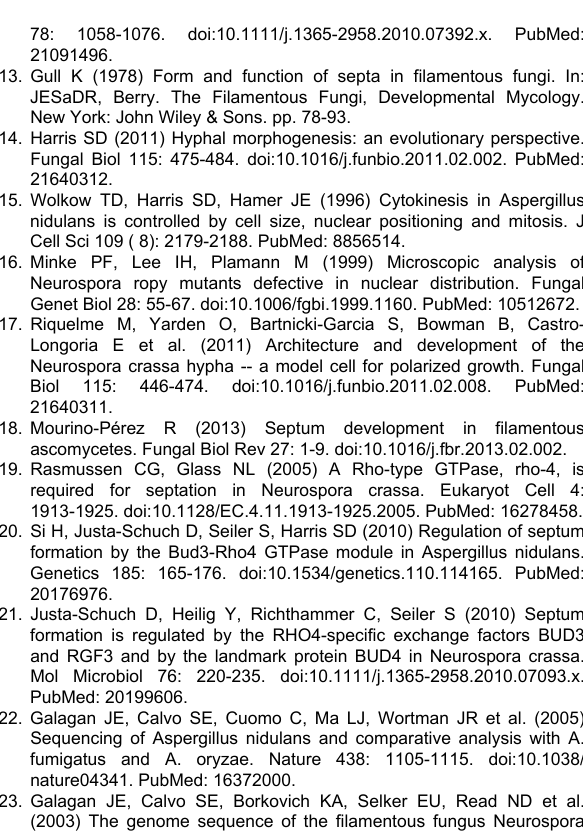
Table S2. Primers used in this study. (DOCX) Movie S1. Time-course of DBF-2-GFP localization during septum formation. DBF-2-GFP formed cortical rings at incipient septation sites that constricted during septum formation and accumulated around the septal pore of the completed septum ( a ) GFP channel; ( b ) RFP channel; ( c ) merged. The plasma membrane was stained with FM4-64. Images were captured at 20 sec intervals. (MOV) Movie S2. Time-course of SID-1-GFP localization during septum formation. SID-1-GFP formed cortical rings at incipient septation sites that constricted during septum formation and accumulated around the septal pore of the completed septum ( a ) GFP channel; ( b ) RFP channel; ( c ) merged. The plasma membrane was stained with FM4-64. Images were captured at 20 sec